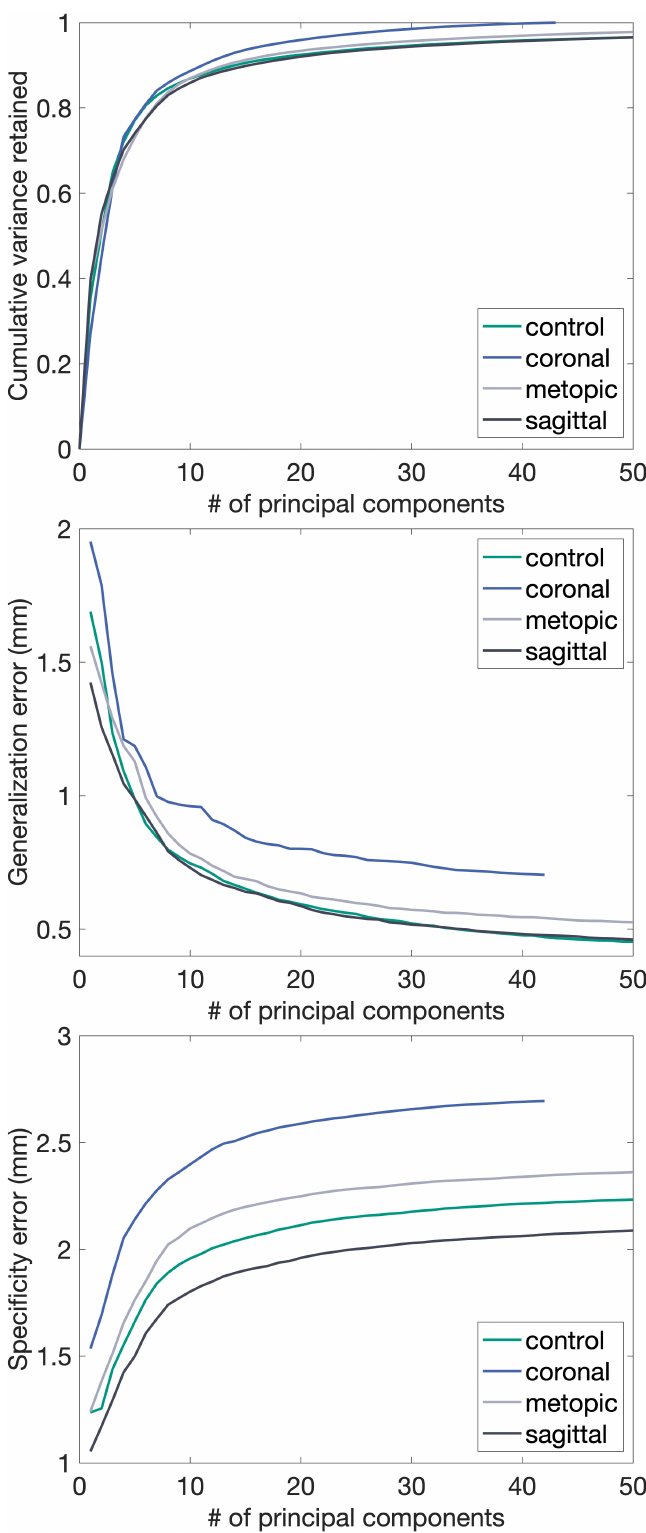
Figure 6. Shape model metrics for the control submodel and the pathology-specific submodels. From top to bottom: compactness, generalization, and